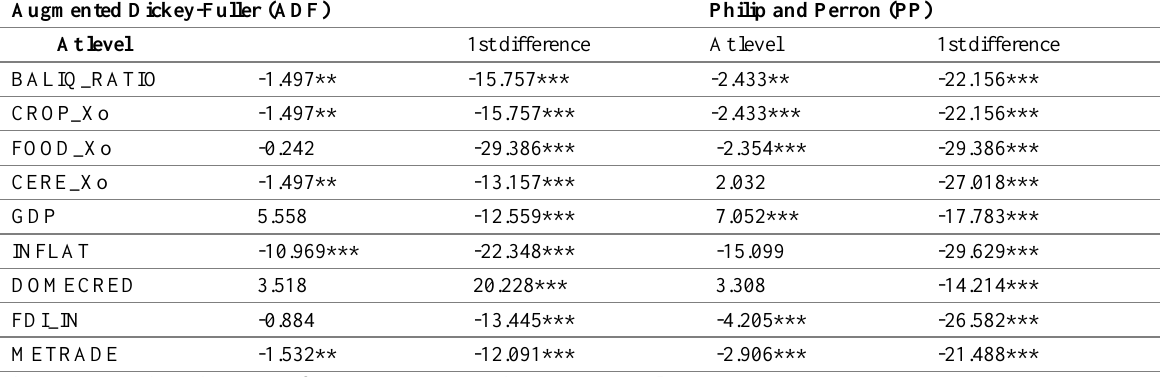
Table 4: ADF and PP Test